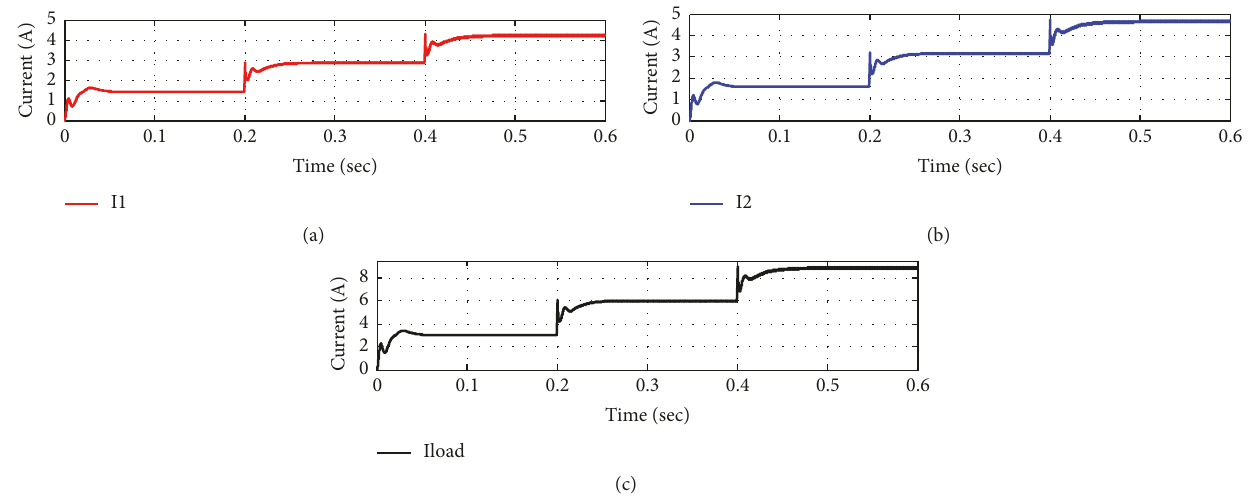
Figure 17: The output current from the simulation results of 10% mismatch case: (a) converter I output current; (b) converter II output current; (c) load